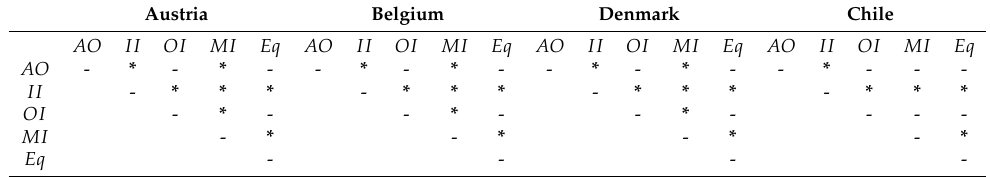
Table 5. Wilcoxon comparison for different initialization procedures results. Asterisks indicate each comparison in which a statistical difference with 95% confidence was